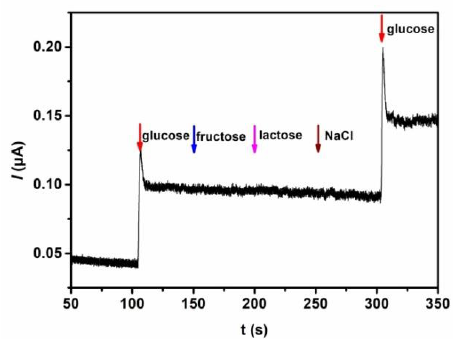
Figure 7. Amperometric response of the GOx/PS- b -P4VP/Pt to10 µ M glucose, fructose, lactose, NaCl, NaCl, and glucose. and glucose. Polymers 2018 , 10 , x FOR PEER REVIEW